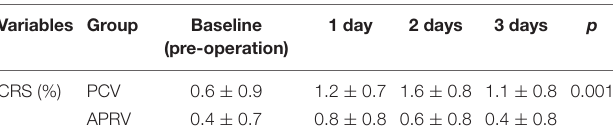
CRS, Chest radiographic scores. Values are expressed as means ± SD.